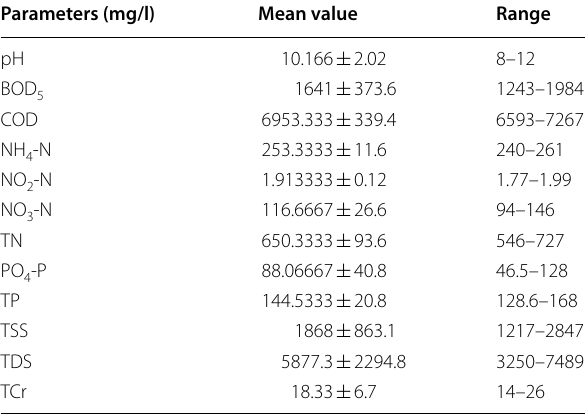
Table 1 Characteristics of Modjo tannery raw wastewater